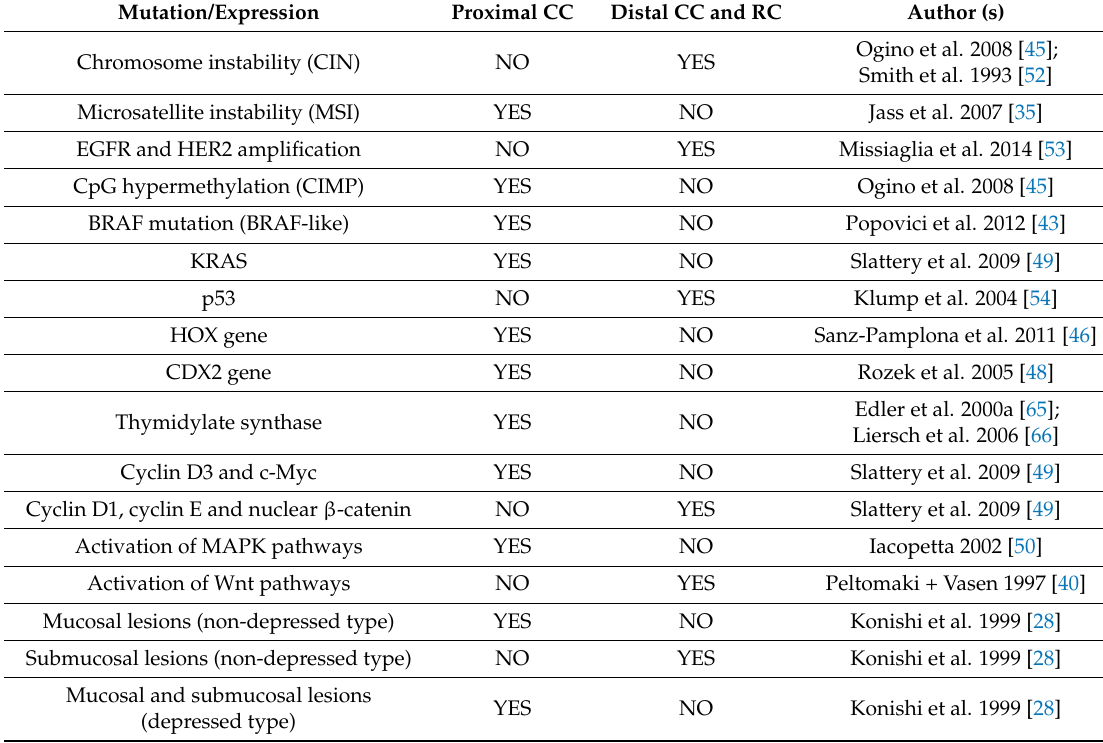
Table 2. Differences in carcinogenesis, molecular genetic profile, histopathology, and biology of sporadic colon cancer (CC) compared with rectal cancer